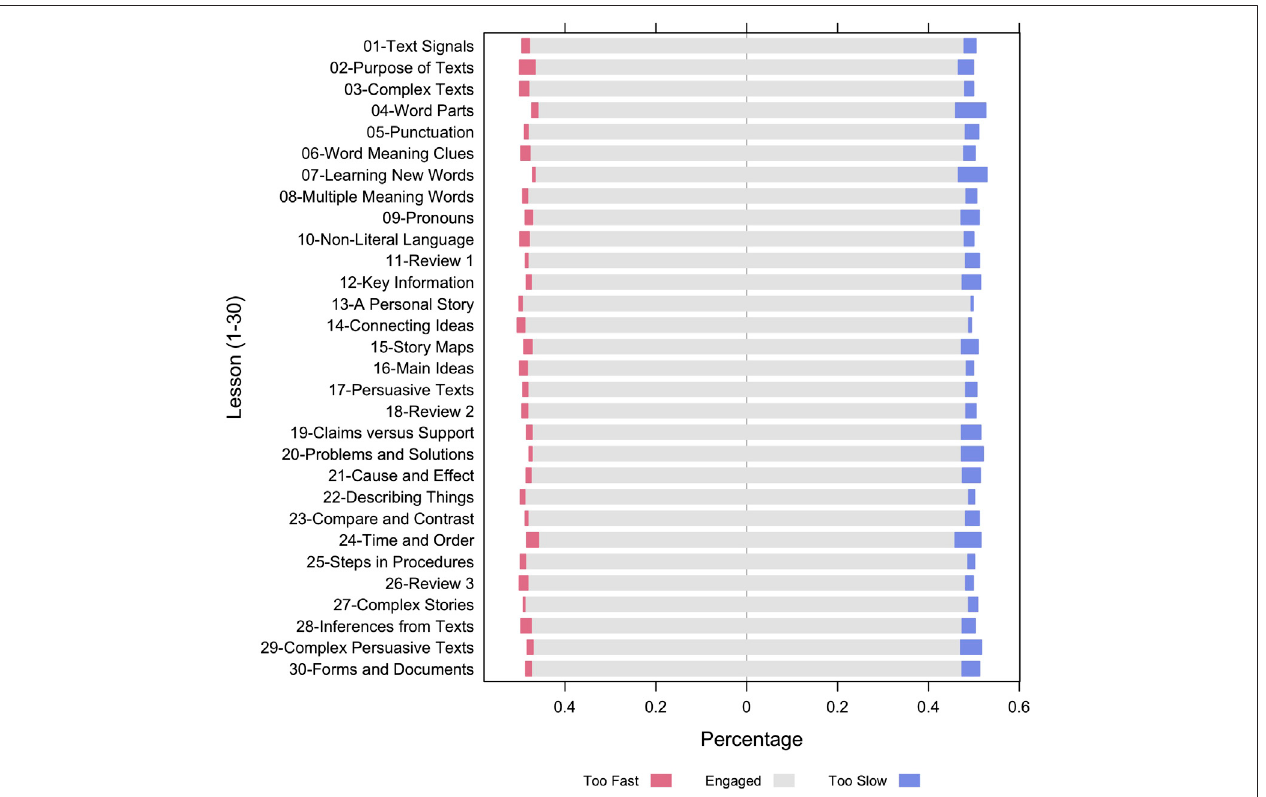
FIGURE 3 | Proportions of disengaged question-answer observations from 252 participants in 30